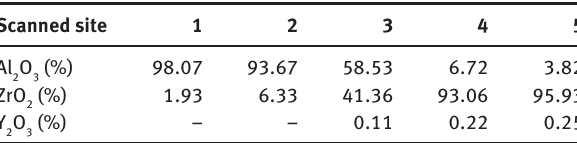
Table 2 Composition of scanned sites of corundum and zirconia particles in Figure 7 by EDS.